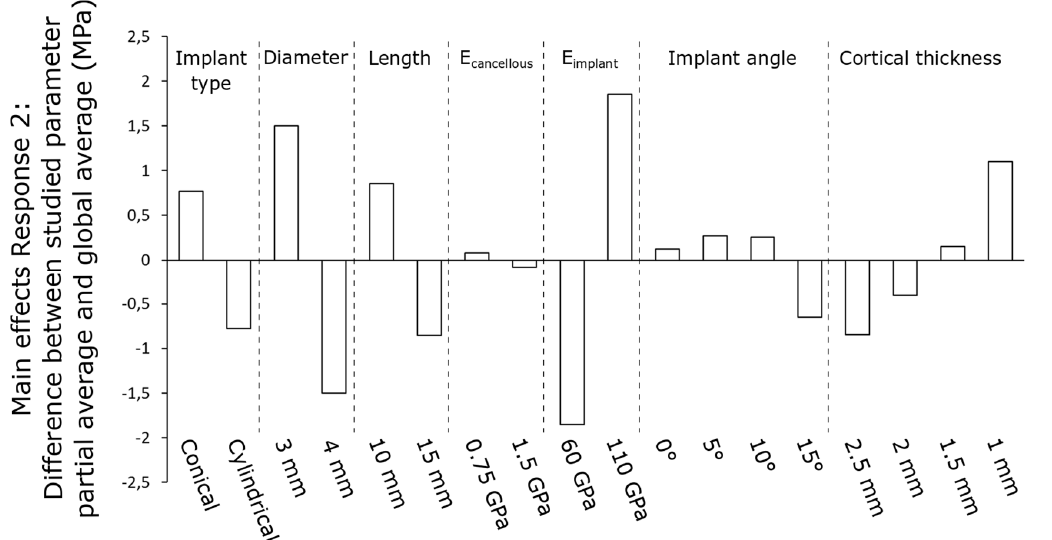
Figure 4. Main effects of parameters on Response 2 (stress jump between cortical bone and implant). Figure 4. Main e ff ects of parameters on Response 2 (stress jump between cortical bone and